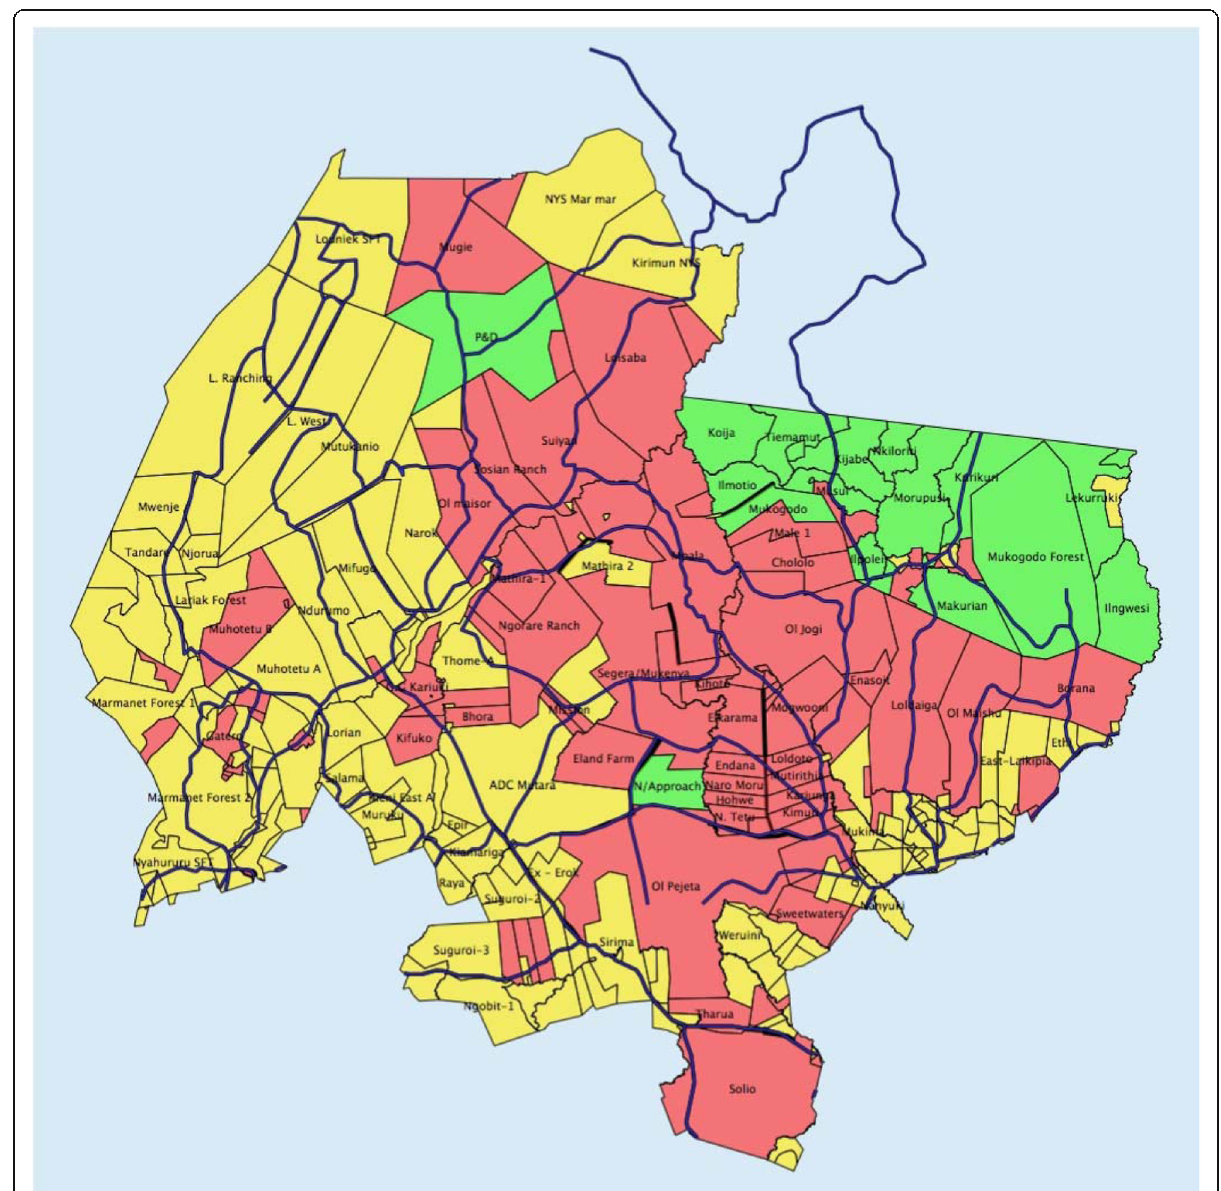
Figure 11 Map of Laikipia County with mixed land use patches and public road networks. Green patches are group ranches, designated by the government in the 1970s as communally governed land. Red patches are private farms/ranches, most of which originated during the colonial period (1890s to 1960s). Yellow patches are either government-owned or absentee-owned lands, many of which have no fencing or regulation of their use or borders. Public roads are indicated in dark blue lines across the map. Although these roads traverse private properties, individuals